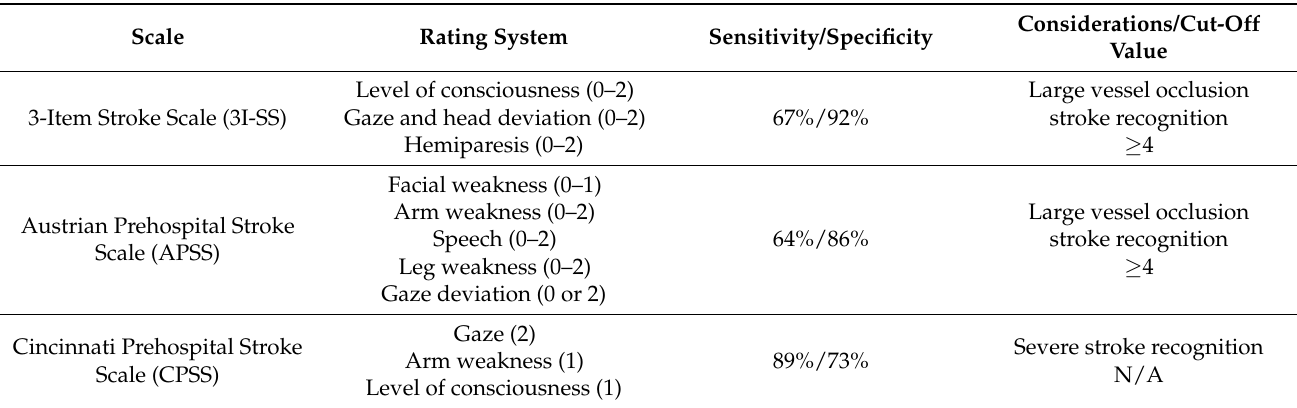
Table 1. Selected abbreviated prehospital stroke scales